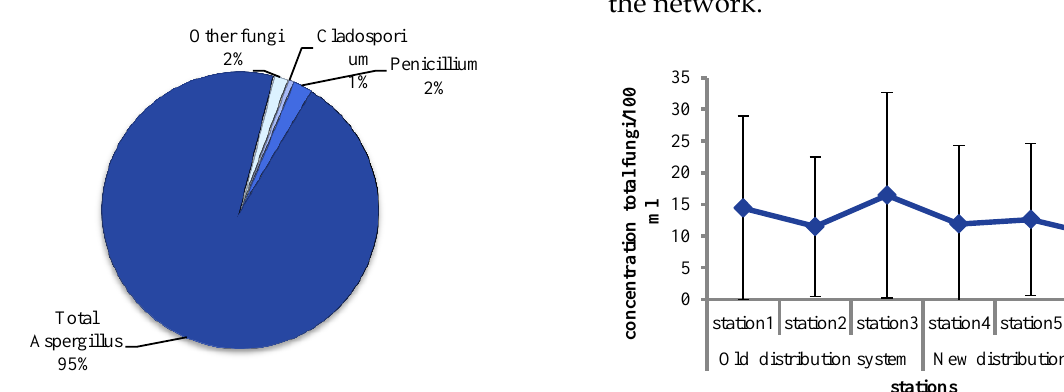
Figure 2. Percentage of fungi isolated in spring seasons sampling water distribution Table 1. Average concentration of fungi (number /100ml) water distribution, measured in two seasons